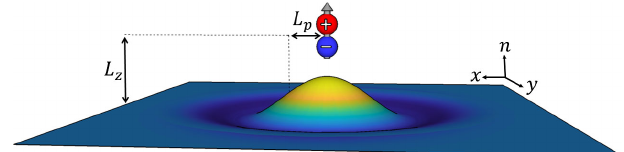
FIG. 7. The polaron model presented here assumes a single IX in the upper layer, interacting with a bath of IXs in the lower layer. The presence of this exciton causes changes in the density distribution of the IX fluid, which can be described as coupled acoustoelectric waves or polarons. The breadth of the polaron, L p , is determined by the strength of the interlayer dipolar coupling, which itself is highly dependent on the separation between layers, L z